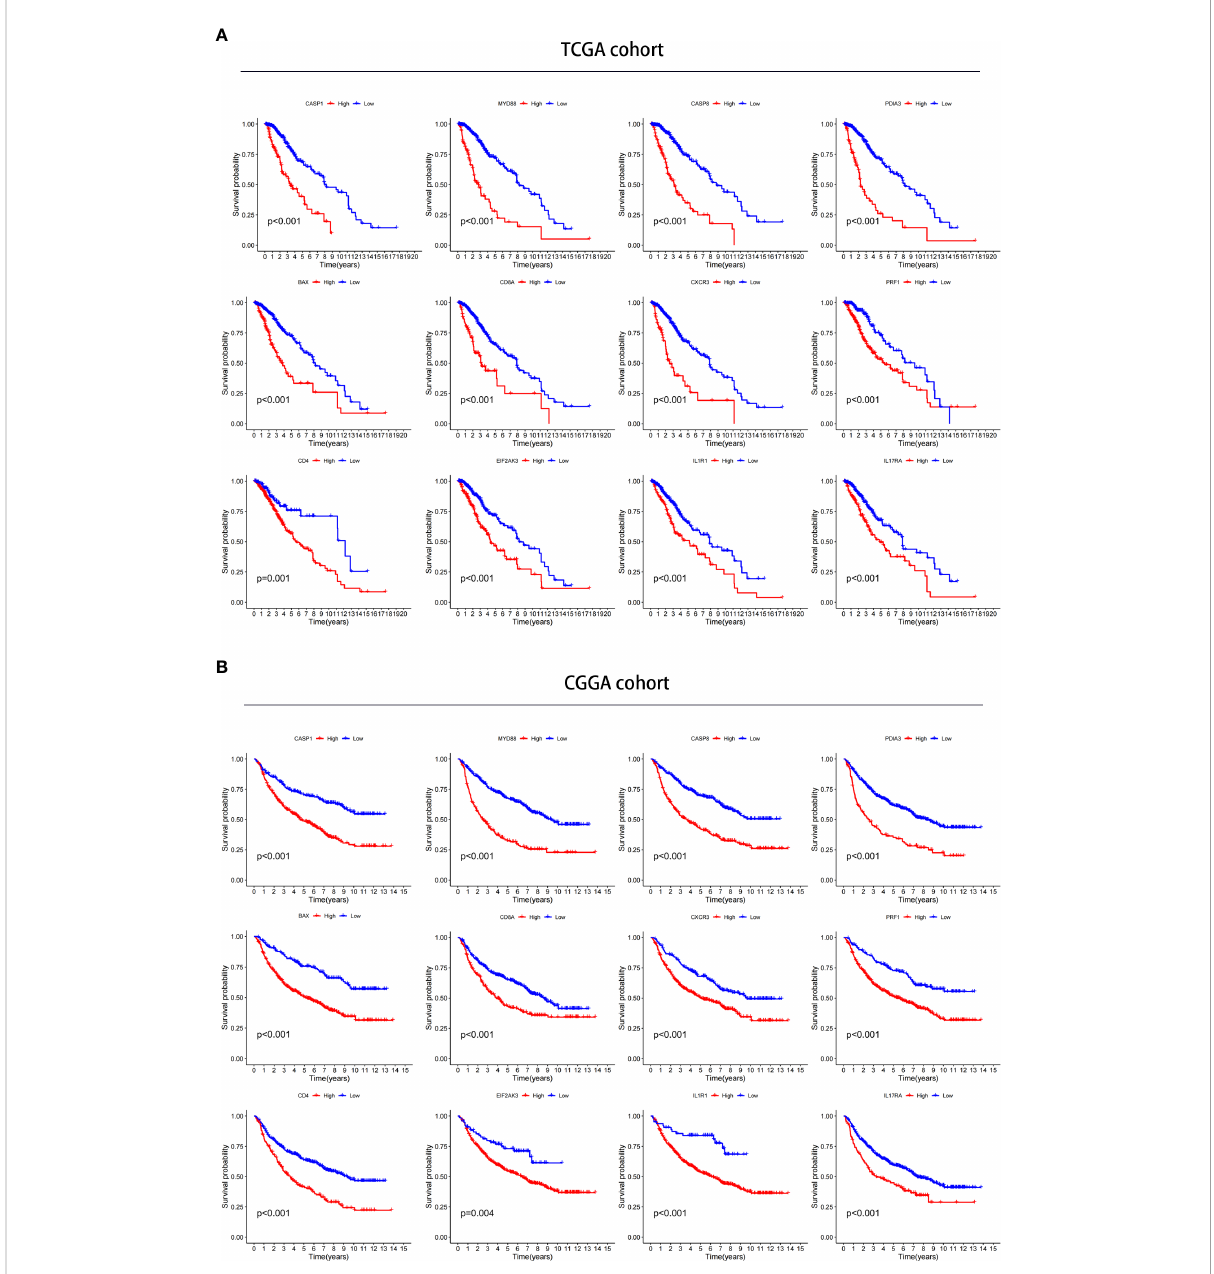
FIGURE 11 Veri fi cation of the prognostic value in TCGA and CGGA databases. (A, B) Kaplan – Meier analysis of 12 ICD-related risk genes for patients in TCGA (A) and CGGA (B)